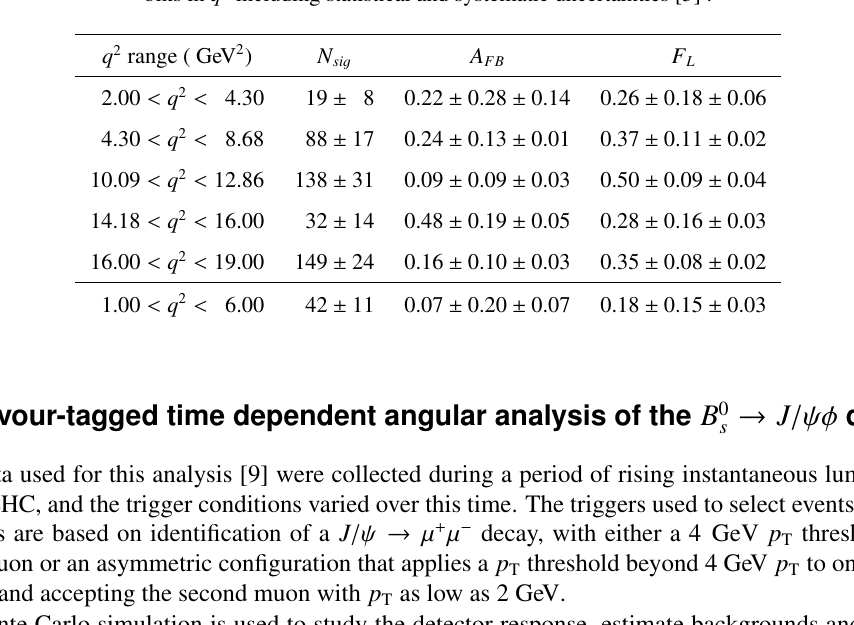
Table 1. Summary of the fit results for the di ff erent bins of q 2 . Number of signal events N si g from the mass fit and its statistical uncertainty, forward backward asymmetry A FB and longitudinal polarisation F L for di ff erent bins in q 2 including statistical and systematic uncertainties [5]